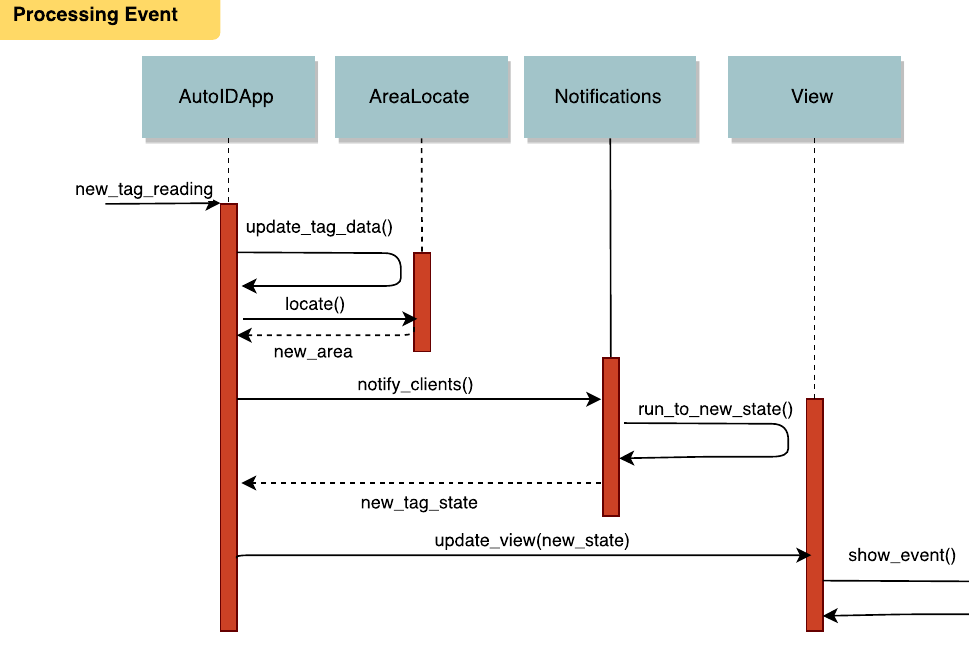
Figure 10. Generic notification sequence